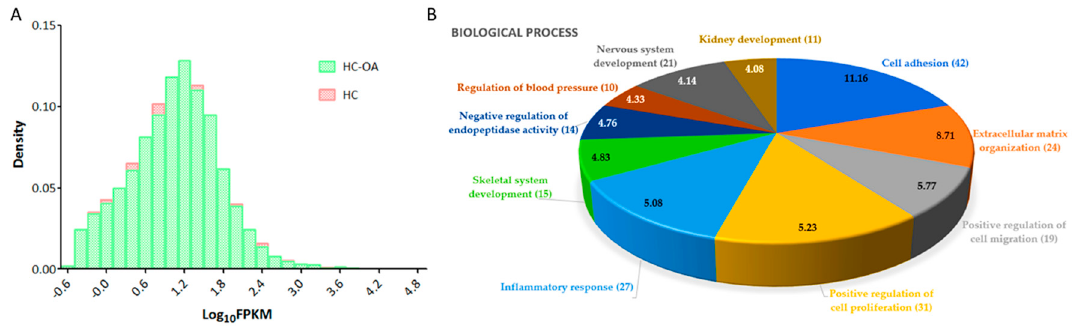
Figure 1. Differential expression analysis of genes in osteoarthritic (OA) knee chondrocytes. ( A ) For gene expressions with fragments per kilobase of transcript per million (FPKM) >0.3, the difference in FPKM performance between normal (HC) and OA (HC-OA) knee chondrocytes is shown in a density plot. The x-axis represents logarithm to the base 10 of FPKM, and the y-axis indicates read density. ( B ) The 495 differentially expressed protein-coding genes in OA knee chondrocytes were input into the DAVID database to determine related biological functions, and these dysregulated genes were related to cell adhesion (42 genes), extracellular matrix organization (24 genes), positive regulation of cell migration (19 genes), positive regulation of cell proliferation (31 genes), inflammatory response (27 genes), skeletal system development (15 genes), negative regulation of endopeptidase activity (14 genes), regulation of blood pressure (10 genes), nervous system development (21 genes), and kidney development (11 genes). The selected criteria for functional annotation analysis were Expression Analysis Systematic Explorer (EASE) score = 0.1 and fold enrichment >1.3. The − log ( p value) of each biological term is indicated within the pie chart. Table 1. Top canonical pathways and upstream regulators involved in differentially expressed genes of osteoarthritic (OA) knee chondrocytes.